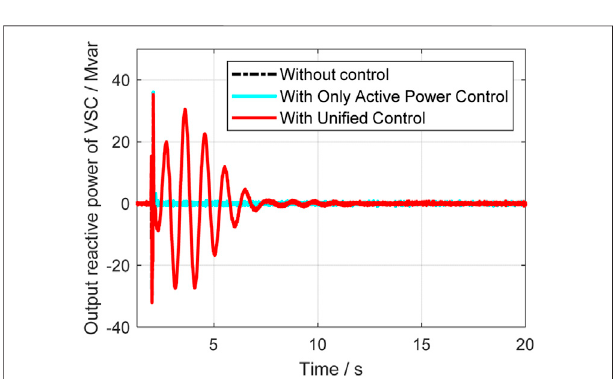
FIGURE 23 | Reactive power of VSC with different schemes.